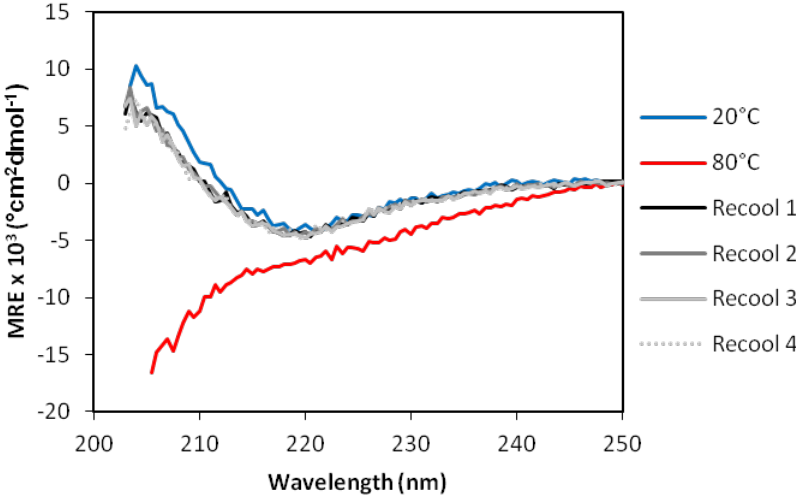
Figure 6. Secondary structure and thermostability of 12Y-2 measured by circular dichroism (CD) spectroscopy. Wavelength scans of 12Y-2 were taken at 20 °C and 80 °C, and repeated four times following cycles of heating to 80  C and cooling to 20 °C (Recool